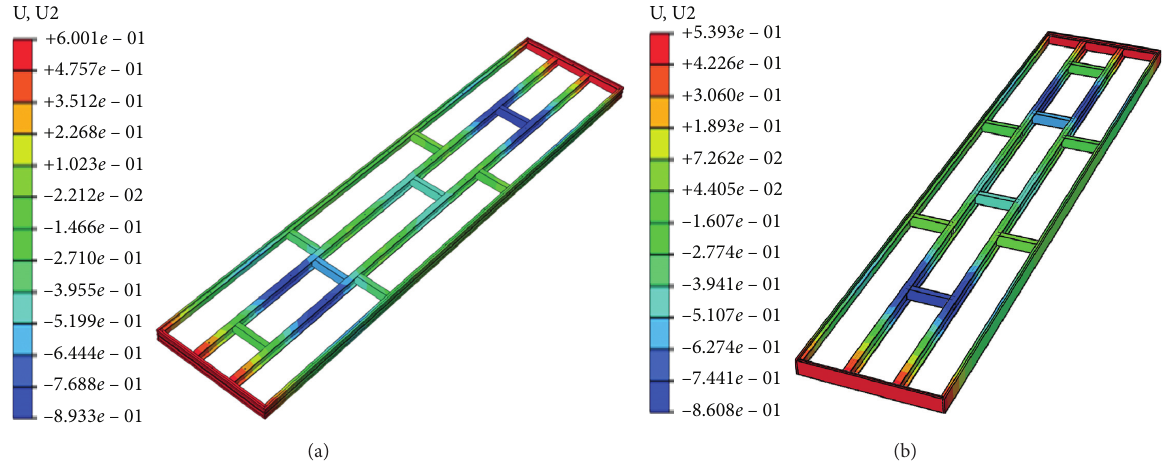
Figure 26: Deflections of the frame (unit: mm). (a) Refined model. (b) General model.